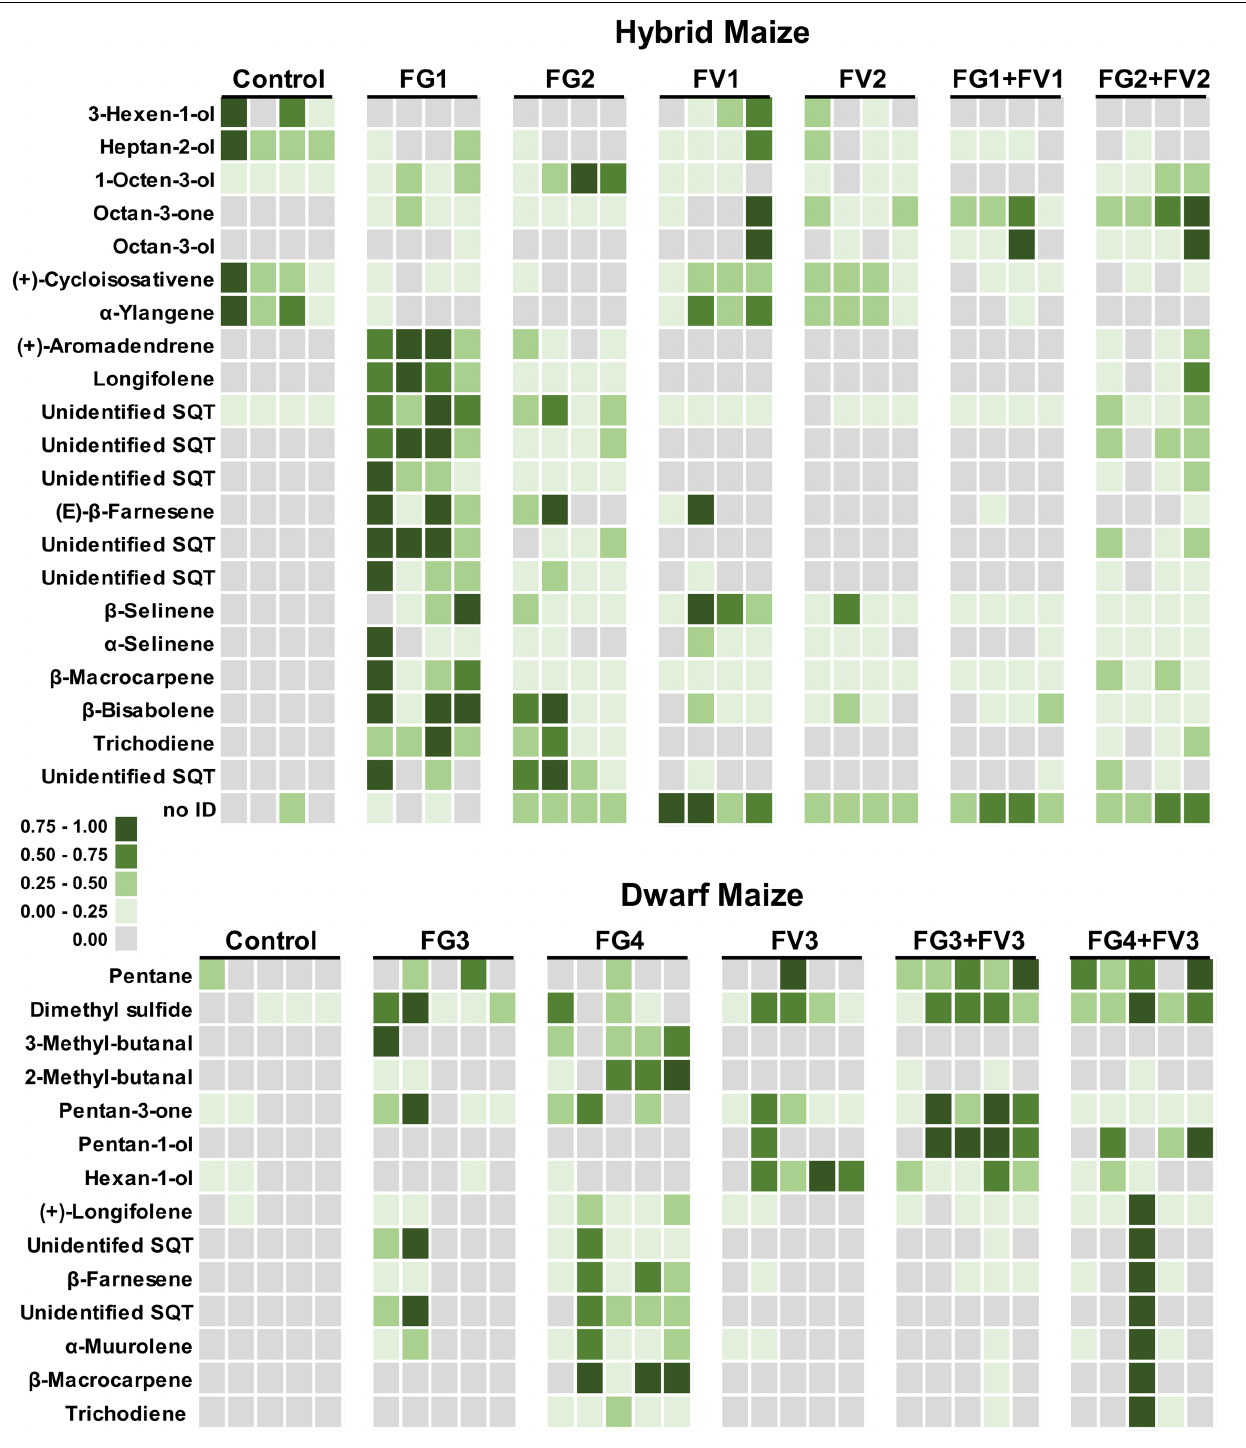
Frontiers in Plant Science |